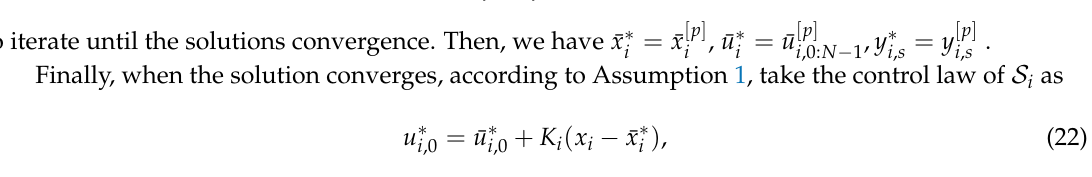
Algorithm 1: Enhancing Strong Neighbor-Based Optimization